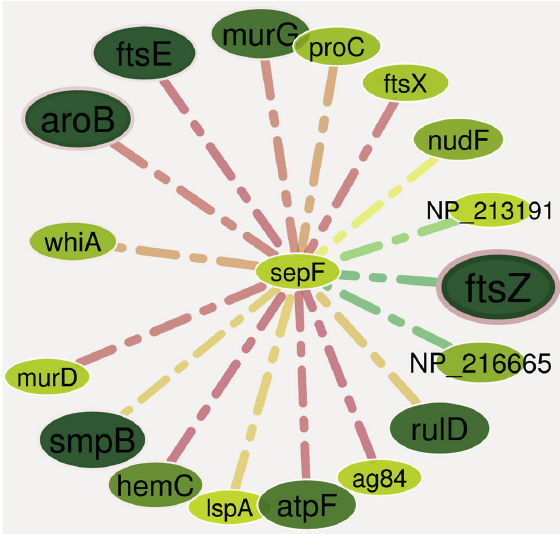
Figure 2 - Sub web to SepF and FtsZ. The sub web to SepF shows the strong interaction between this protein with FtsZ. Looking on the supplementary material at column vl_pdbscore, the value is more than 0.9, which corresponds to a score based on experimental results.